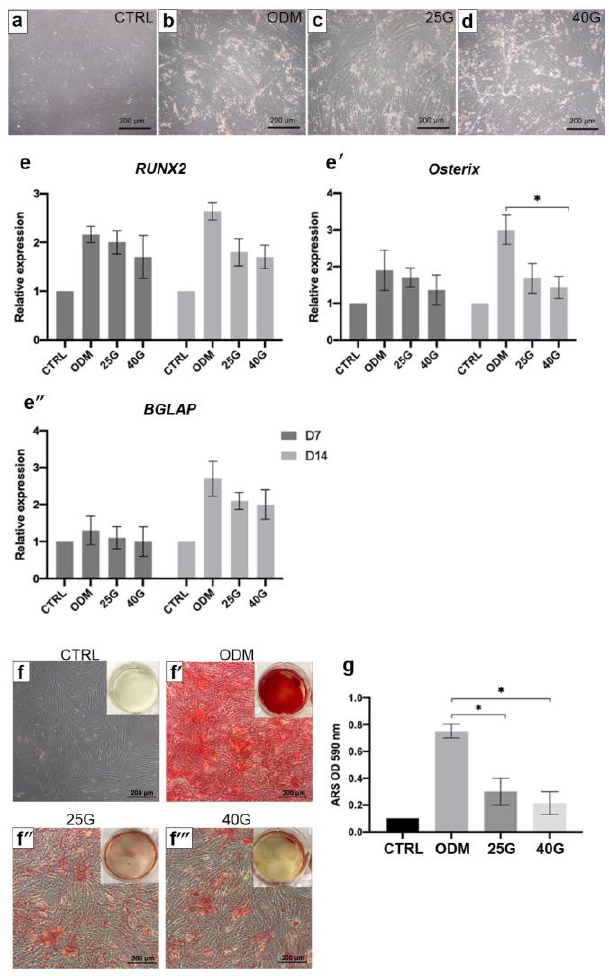
Figure 2. The effect of high levels of glucose on the in vitro osteogenic differentiation of MSCs. The MSCs were cultured in growth medium (control, CTRL), ODM (5.5 mM glucose), ODM with 25 mM glucose (25G), and ODM with 40 mM glucose (40G). Morphology of MSCs in each condition was observed ( a – d ). The expressions of RUNX2 ( e ), Osterix ( e ’ ), and BGLAP ( e ’’ ) were investigated at day 7 and 14. Gene expression is presented as relative to the CTRL. Alizarin Red S staining at day 14 is shown ( f – f ’’’ ). Semi-quantitative analysis of ARS staining was performed by dye extraction ( g ). All data are presented as the means ± SEM from three independent experiments. * p value < 0.05 is considered statistically significant.